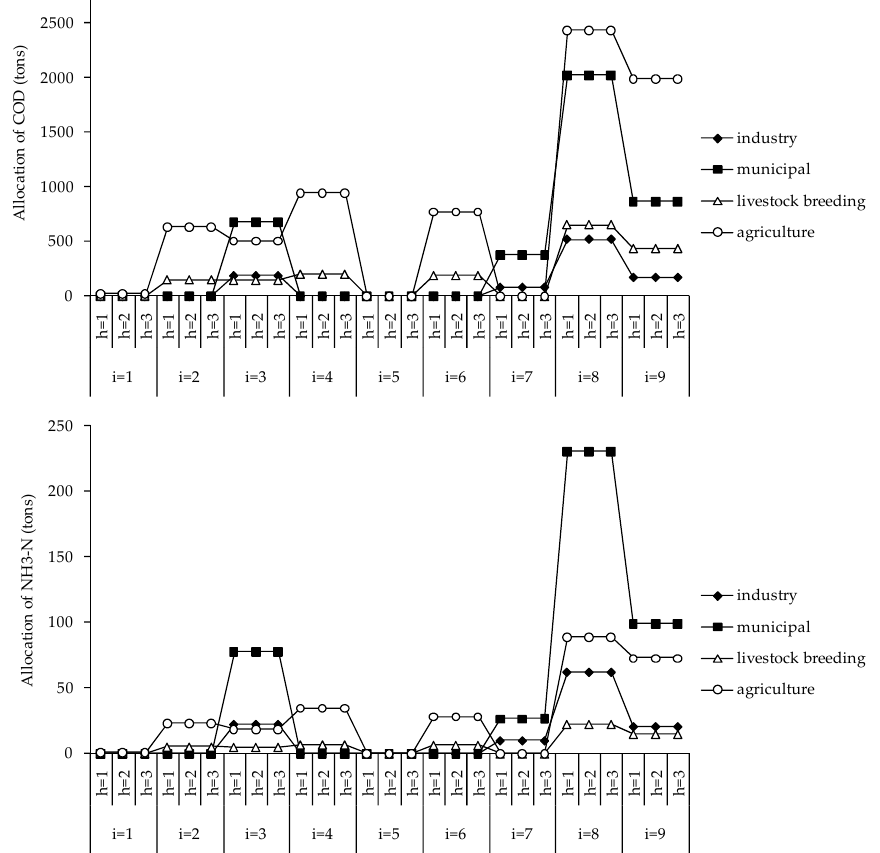
Figure 4. Allocation amounts of the controlled pollutants in Period 1.